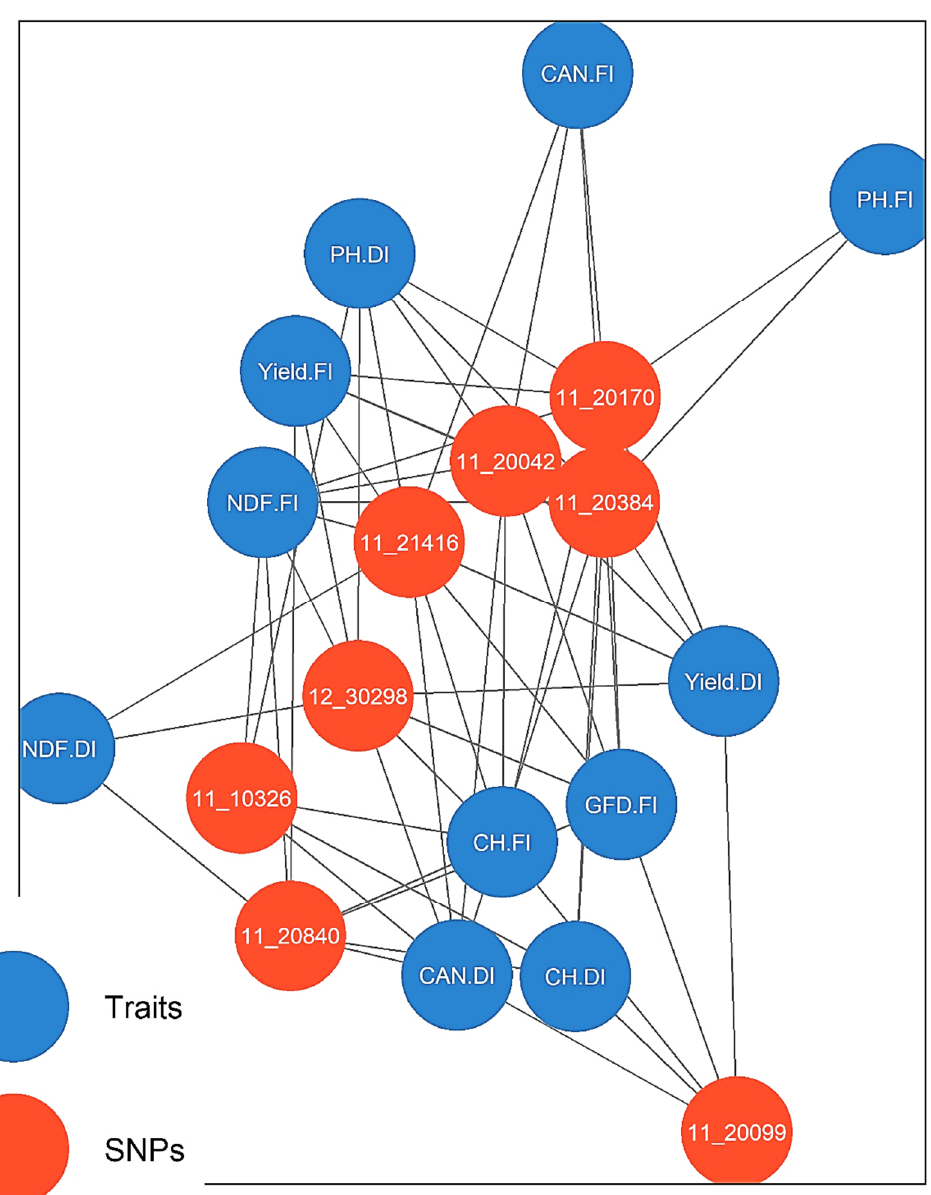
Figure 7. Summary of the genome-wide association scans for the significant pleiotropic effect markers associated with the Number of Days to Flowering (NDF), Canopy Temperature (CAN), Total Chlorophyll Content (CH), Grain-Filling Duration (GFD), Plant Height (PH), and Grain Yield (Yield) in 2019 and 2020 under Full Irrigation (FI) and Deficit Irrigation (DI).